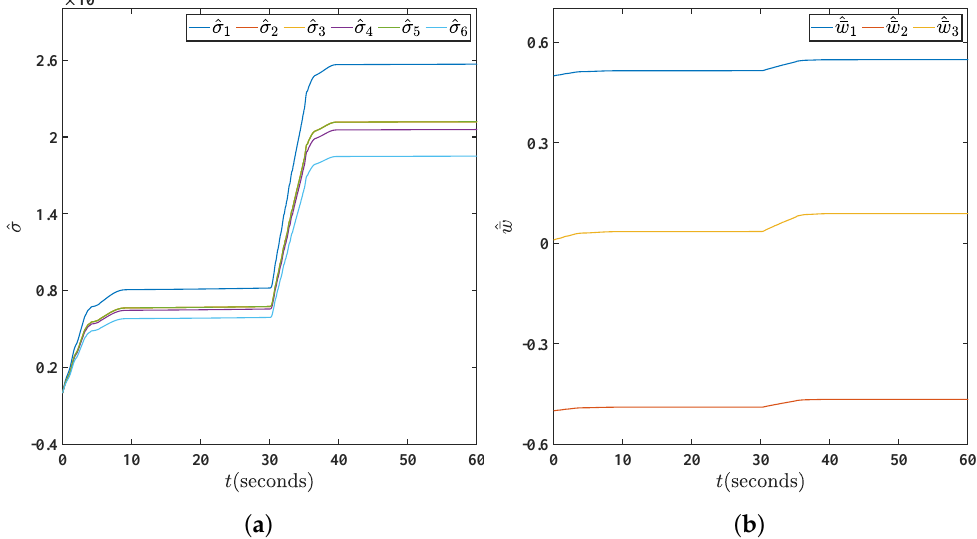
Figure 7. ( a ) Responses of parameter ˆ σ ( t ) using the proposed methodology in fault case with ρ 3 = 0, σ 3 = 1, ρ 5 = 0.6. ( b ) Responses of parameter ˆ¯ w ( t ) using the proposed methodology in fault case with ρ 3 = 0, σ 3 = 1, ρ 5 =